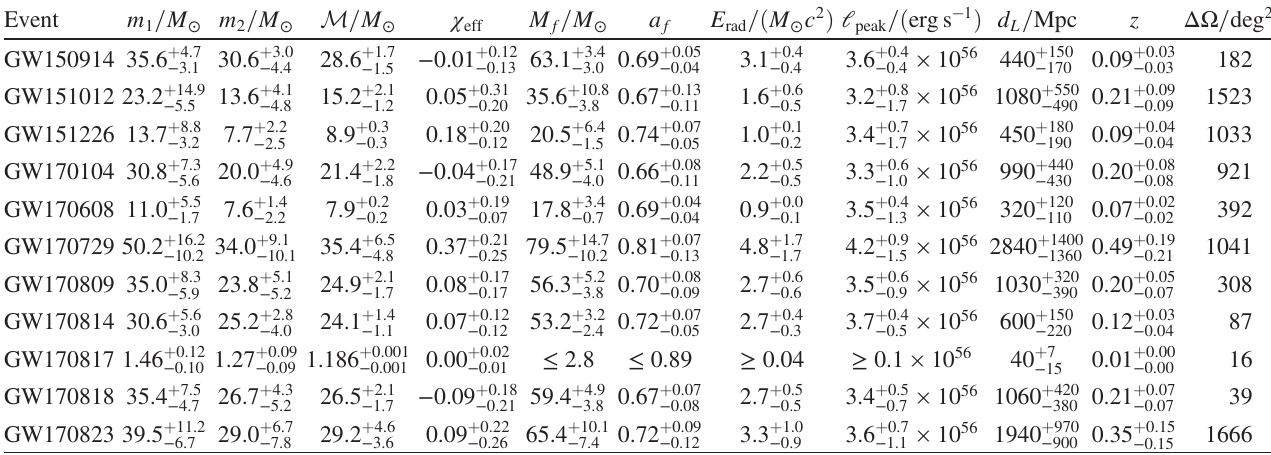
TABLE III. Selected source parameters of the 11 confident detections. We report median values with 90% credible intervals that include statistical errors and systematic errors from averaging the results of two waveform models for BBHs. For GW170817, credible intervals and statistical errors are shown for IMRPhenomPv2NRT with a low spin prior, while the sky area is computed from TaylorF2 samples. The redshift for NGC 4993 from Ref. [94] and its associated uncertainties are used to calculate source-frame masses for GW170817. For BBH events, the redshift is calculated from the luminosity distance and assumed cosmology as discussed in Appendix B. The columns show source-frame component masses m i and chirp mass M , dimensionless effective aligned spin χ , final eff source-frame mass M f , final spin a f , radiated energy E , peak luminosity l , luminosity distance d L , redshift z , and sky localization rad peak ΔΩ . The sky localization is the area of the 90% credible region. For GW170817, we give conservative bounds on parameters of the final remnant discussed in Sec. V